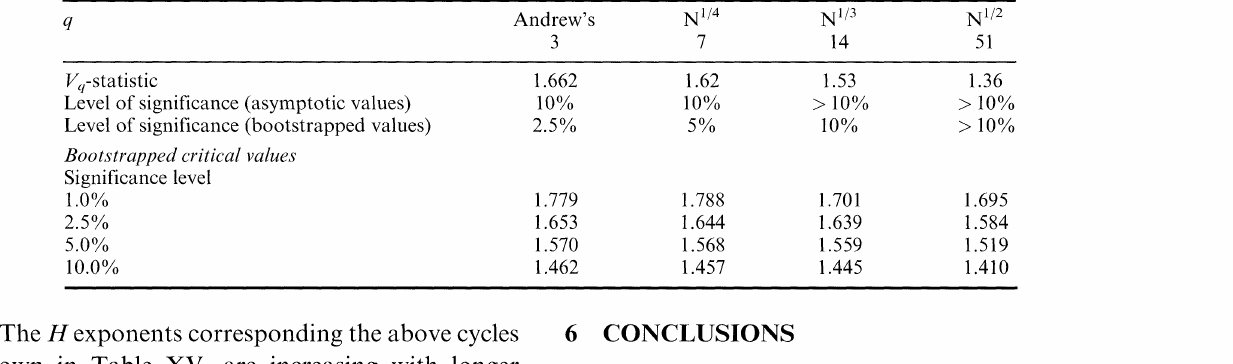
TABLE XIV The modified R/S statistic of the daily FF/GRD returns and bootstrapped critical values of the test